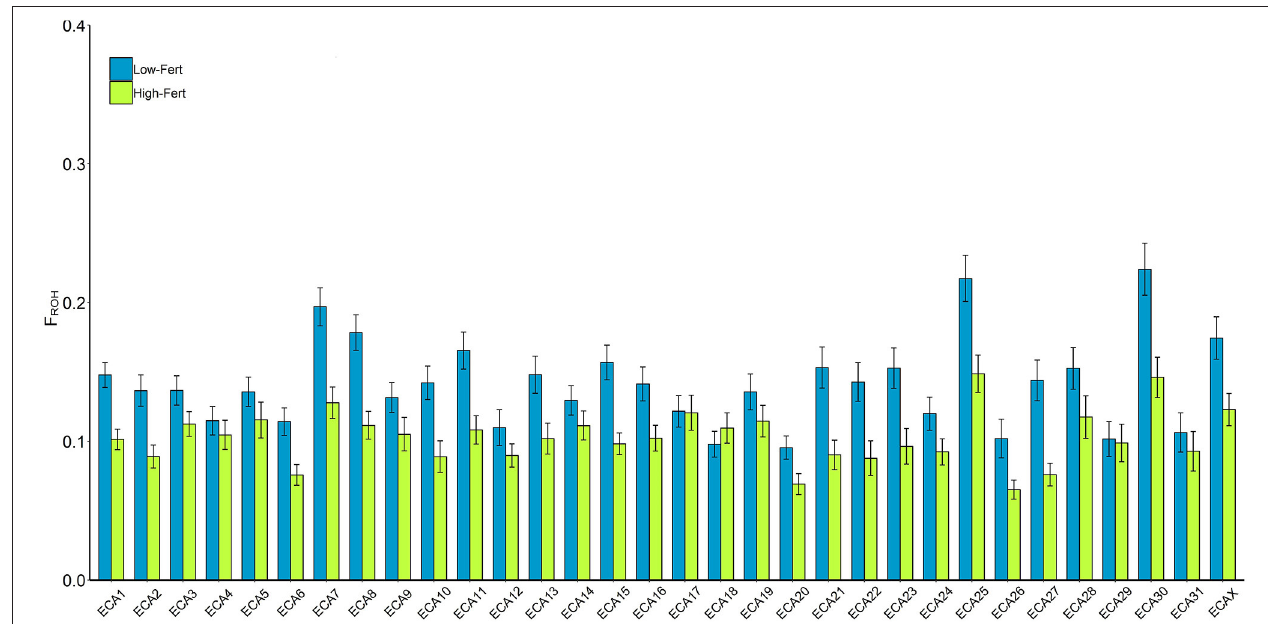
FIGURE 2 | F ROH per chromosome in low (blue) and high (green) fertility groups. The values were estimated as the percentage of each chromosome covered per ROH. *Indicates significant ( p < 0.05) differences within chromosomes between groups.